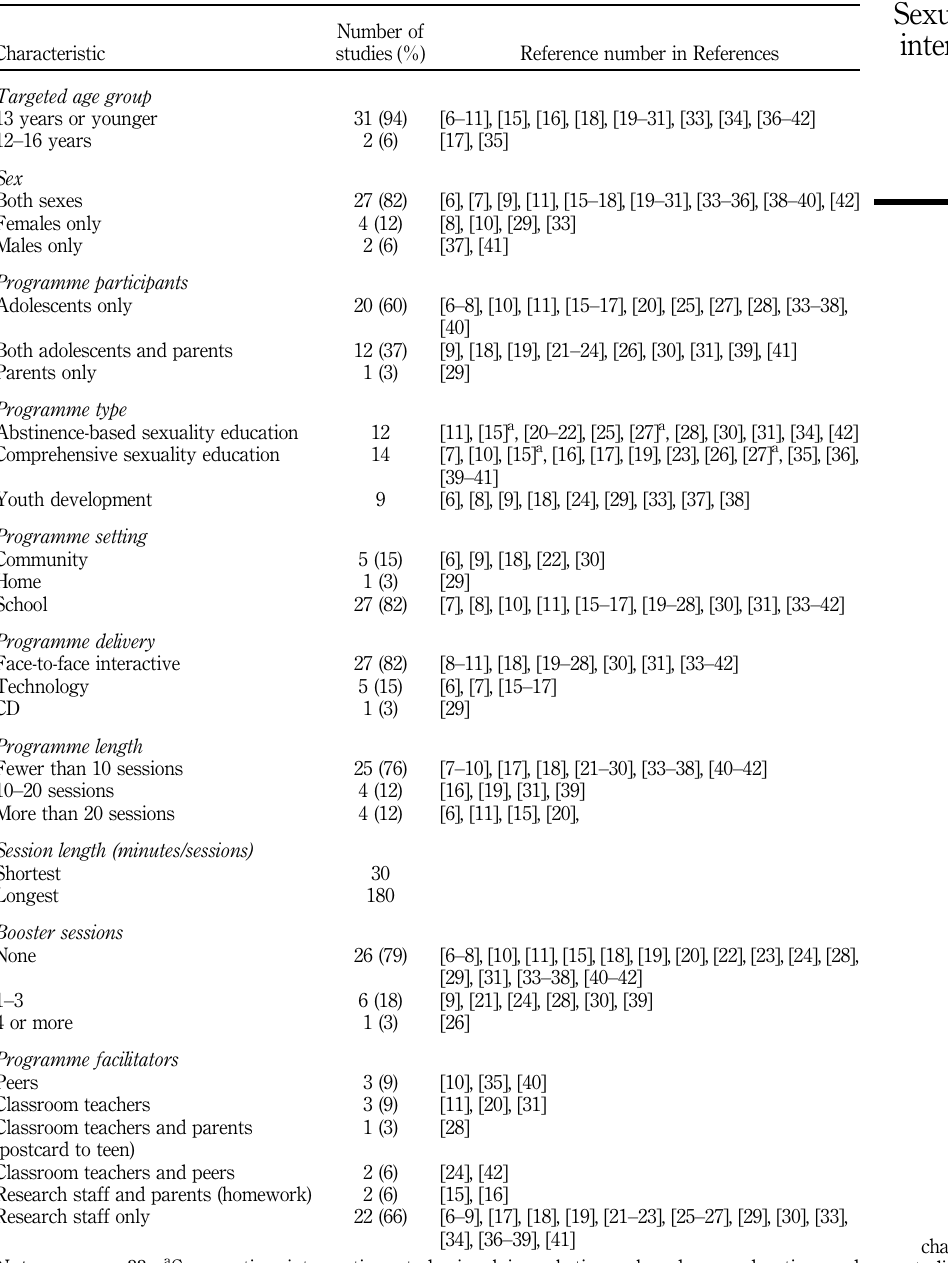
programme characteristics